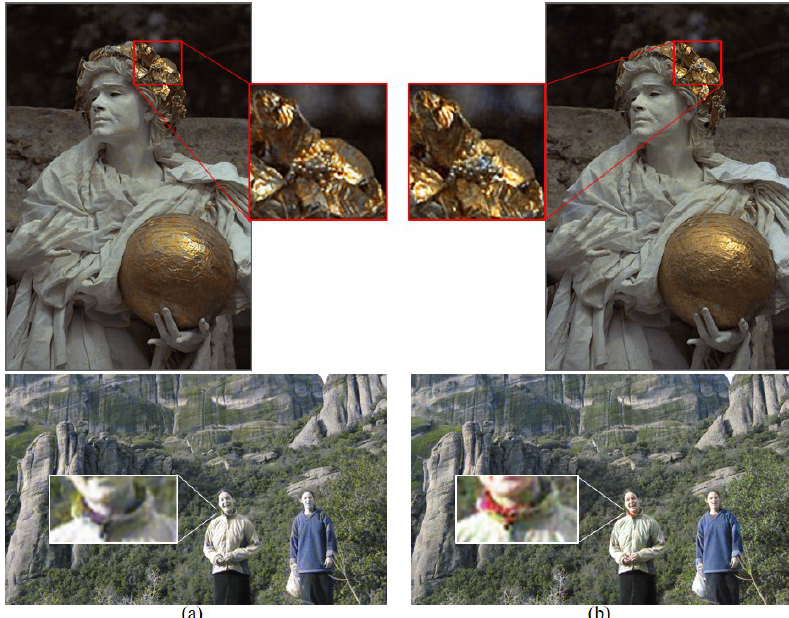
Figure 7. Comparing the reconstructions results with the proposed method on the random RGBW CFA on the Kodak No. 17 and No. 25 images with ( a ) a ratio of 1:2:1:4 of R, G, B, and W pixels ( b ) a ratio of 1:1:1:3 of R, G, B, and W pixels.